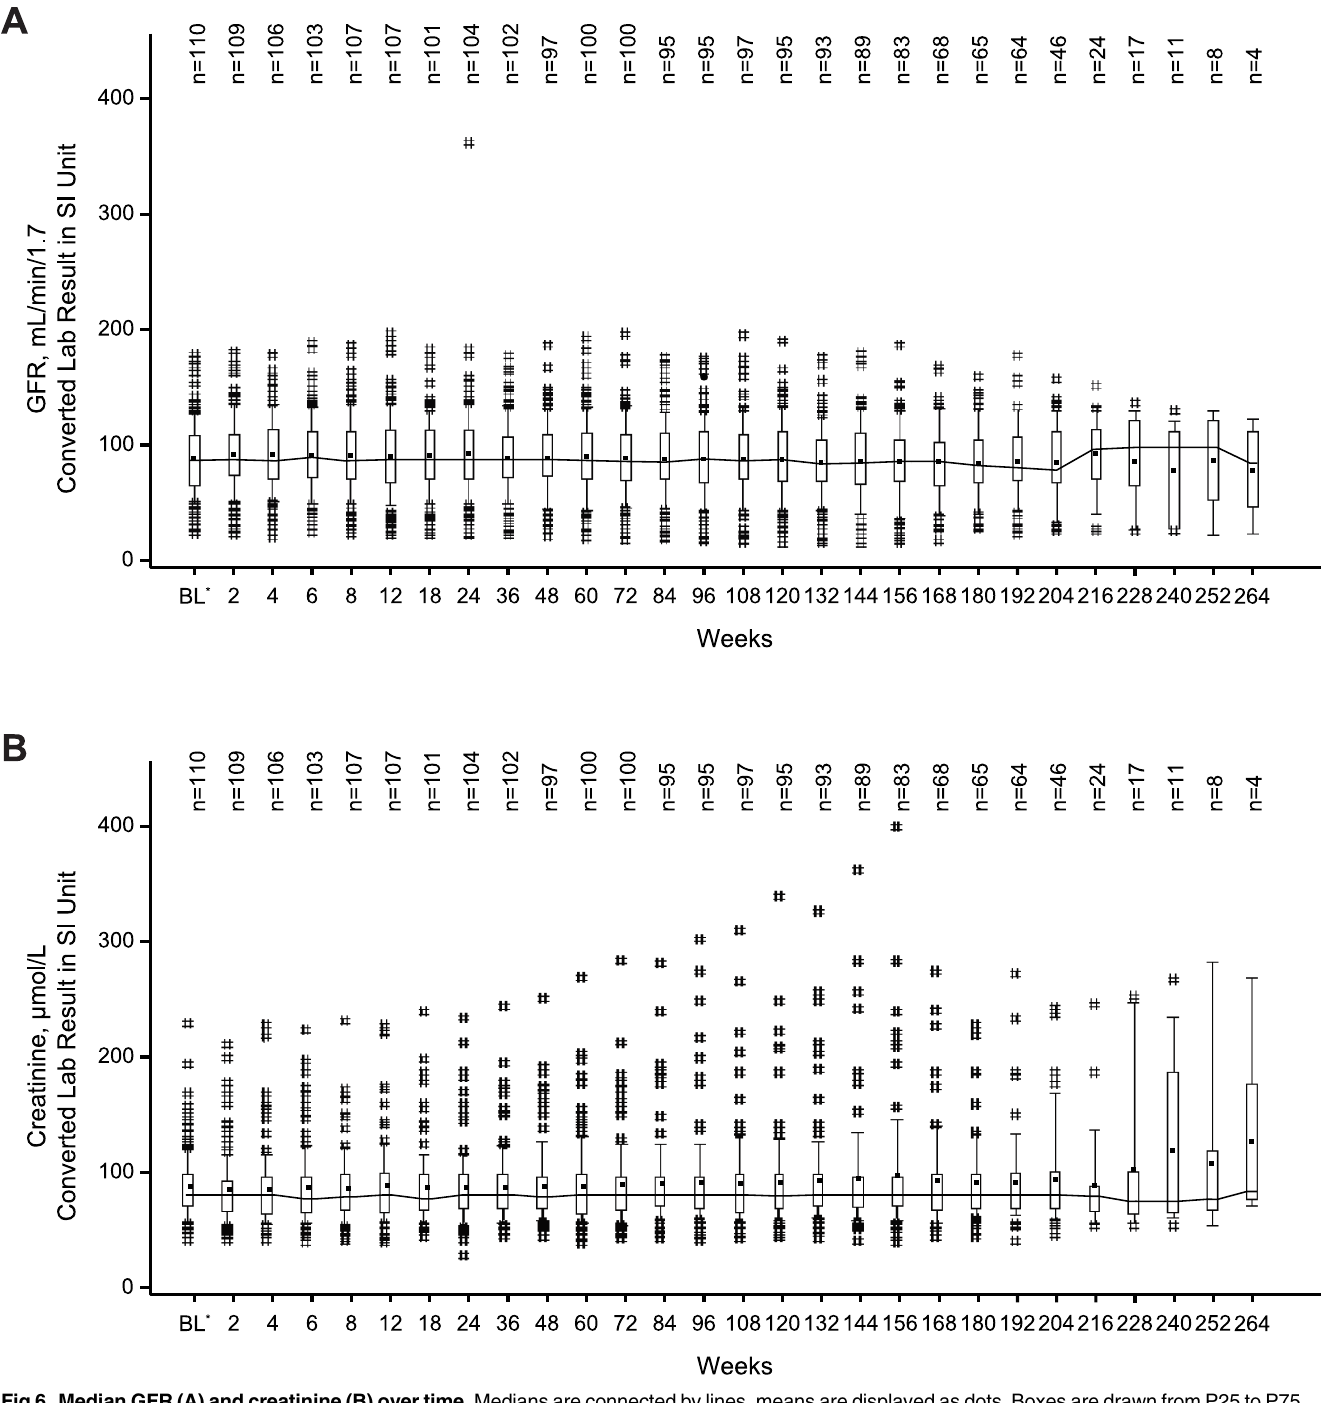
PLOS ONE | https://doi.org/10.1371/journal.pone.0180939 August 9,